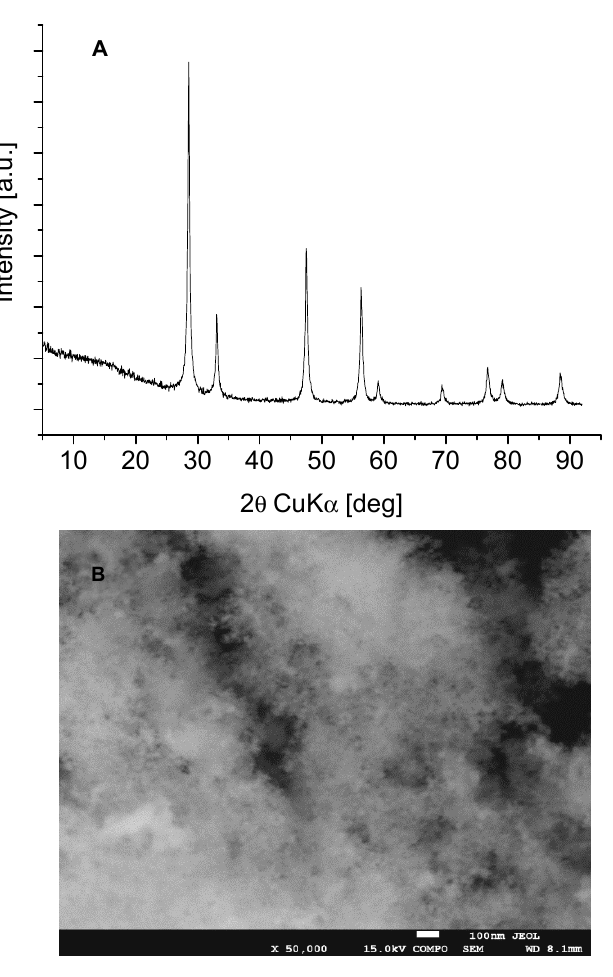
Figure 1. ( A ) - XRD patterns and ( B ) - SEM image of CeO 2 sample. Figure 1. ( A )—XRD patterns and ( B )—SEM image of CeO